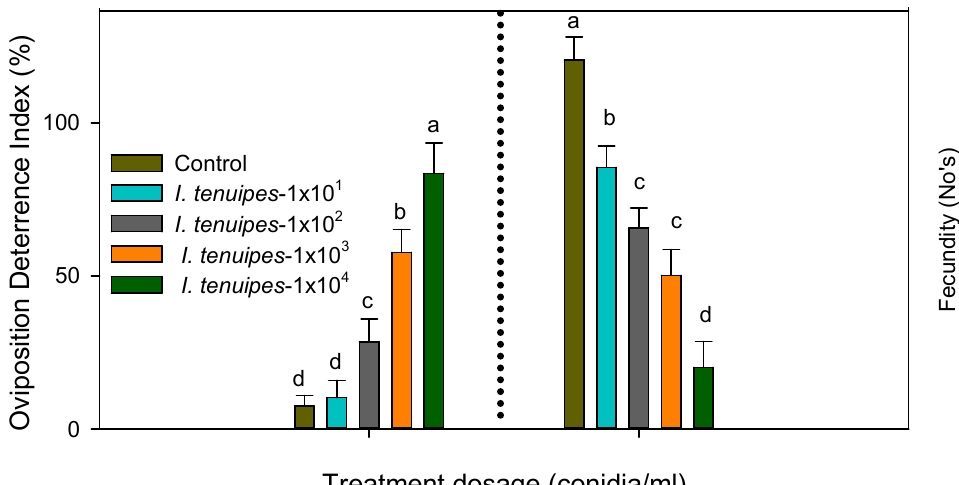
Figure 4. Oviposition deterrent index and fecundity evaluation of My-It against dengue mosquitoes. Means (± SE) followed by the same letters above bars indicated no significant difference ( p ≤ 0.05) using ANOVA analysis. The different letters (a-d) indicate significant differences between the control and treatments.